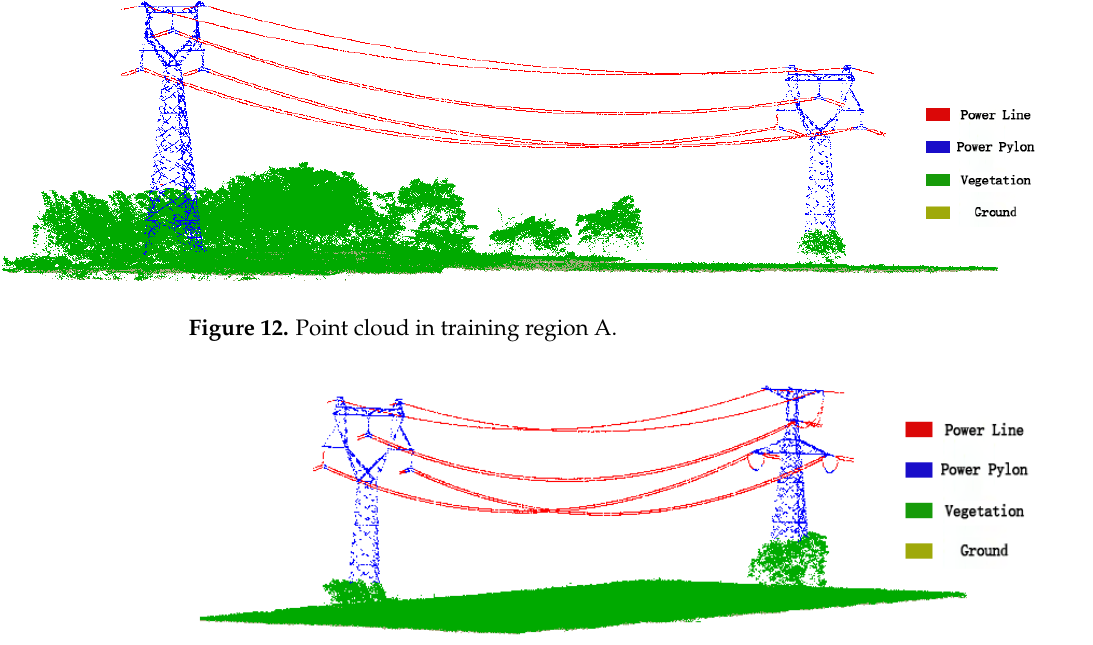
Table 4. Confusion matrix for classification of region C. Overall accuracy: 99.1%